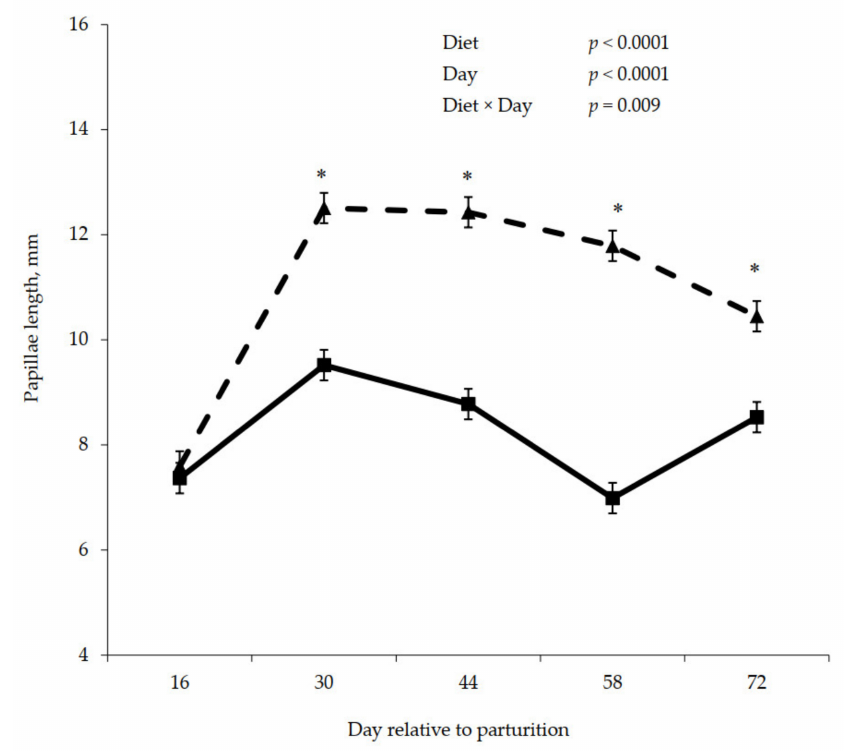
Figure 5. Postpartum rumen papillae length for cows fed control (triangles) or molasses-containing (squares) diets during a 60 day dry period (error bars = pooled standard error of the mean, Experiment 2, n = 3). * Within each day, means differ at p ≤